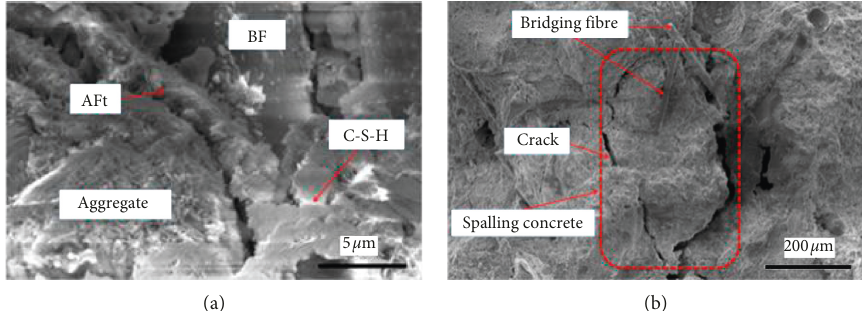
Figure 10: Bonding between BF and C-S-H matrix: (a) interface bonding and (b) crack control.